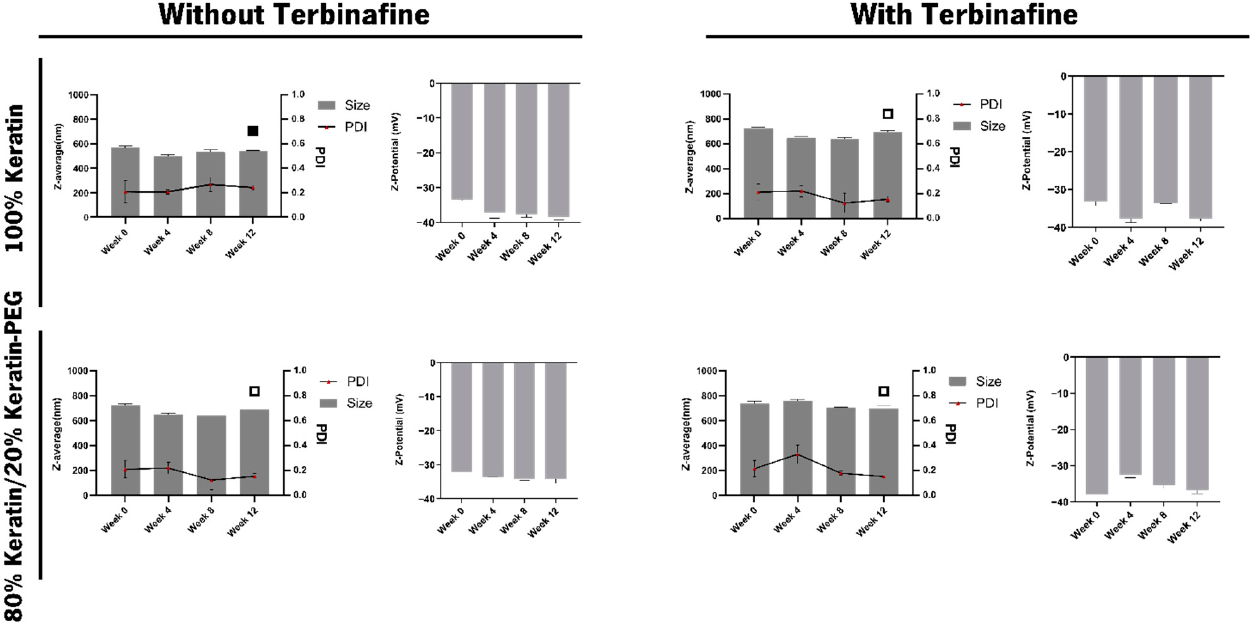
Figure 2. Stability characterization of keratin-based particles, with and without terbinafine, during storage at 4 °C. The data represent the mean ± SD of the Z-Average (nm), PDI and surface charge (z-Potential (mV)) for 14 weeks. The data were analyzed by Tukey’s multiple comparison test. Samples marked with ▪ , ▫ show significative differences ( p -value 0.001 ( ▫ ), p -value 0.0001 ( ▪ )) when compared with week 0.